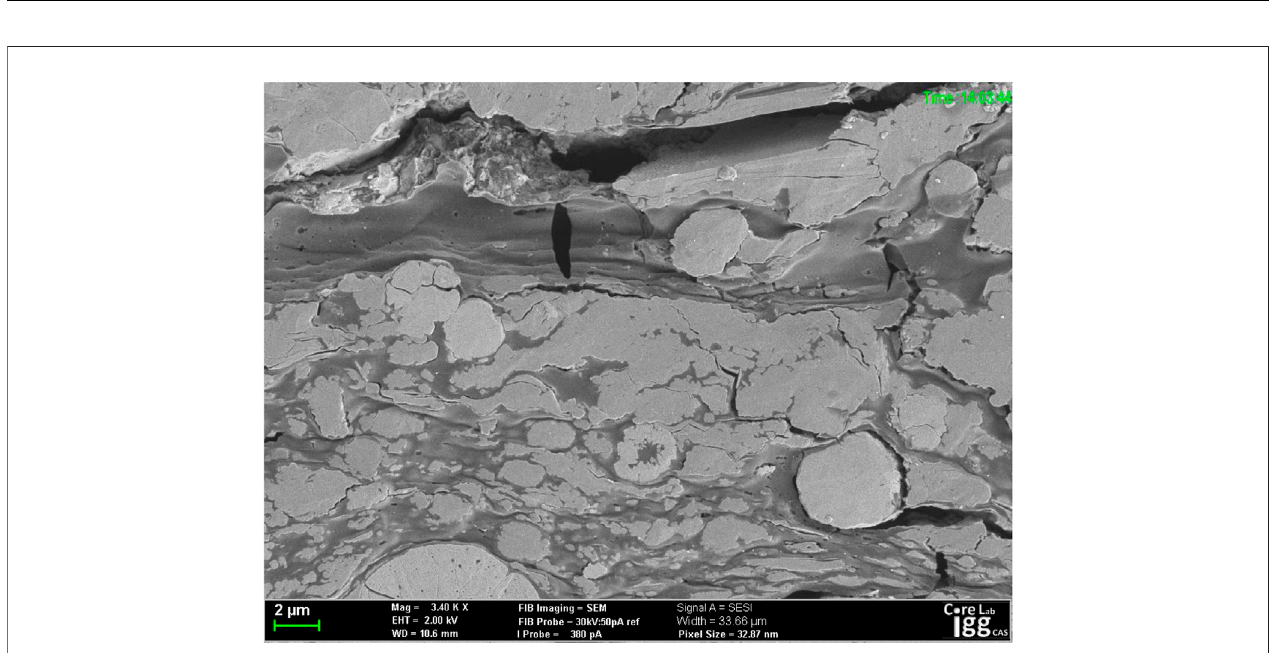
FIGURE 9 | Crack distribution in a sample at 700 ° C in the parallel and vertical bedding directions.